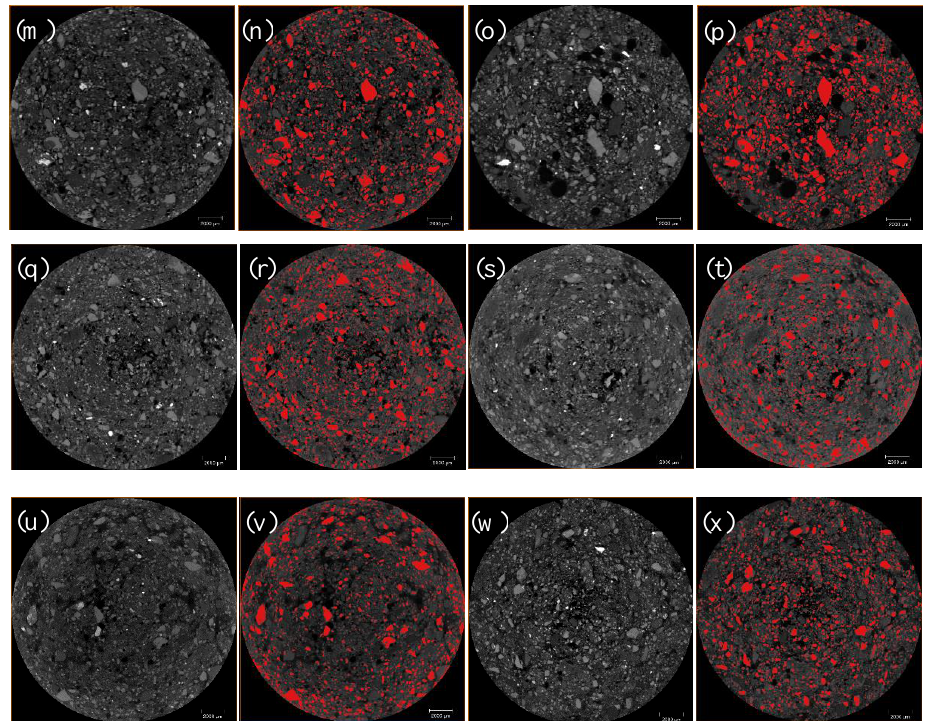
Figure 13. Threshold segmentation of the tailings sand particles. ( a , b ) First-level head of the 30% fine content; ( c , d ) Second-level head of the 30% fine content; ( e , f ) Third-level head of the 30% fine content; ( g , h ) Fourth-level head of the 30% fine content; ( i , j ) First-level head of the 50% fine content; ( k , l ) Second-level head of the 50% fine content; ( m , n ) Third-level head of the 50% fine content; ( o , p ) Fourth-level head of the 50% fine content; ( q , r ) First-level head of the 70% fine content; ( s , t ) Second-level head of the 70% fine content; ( u , v ) Third-level head of the 70% fine content; ( w , x ) Fourth-level head of the 70% fine content.